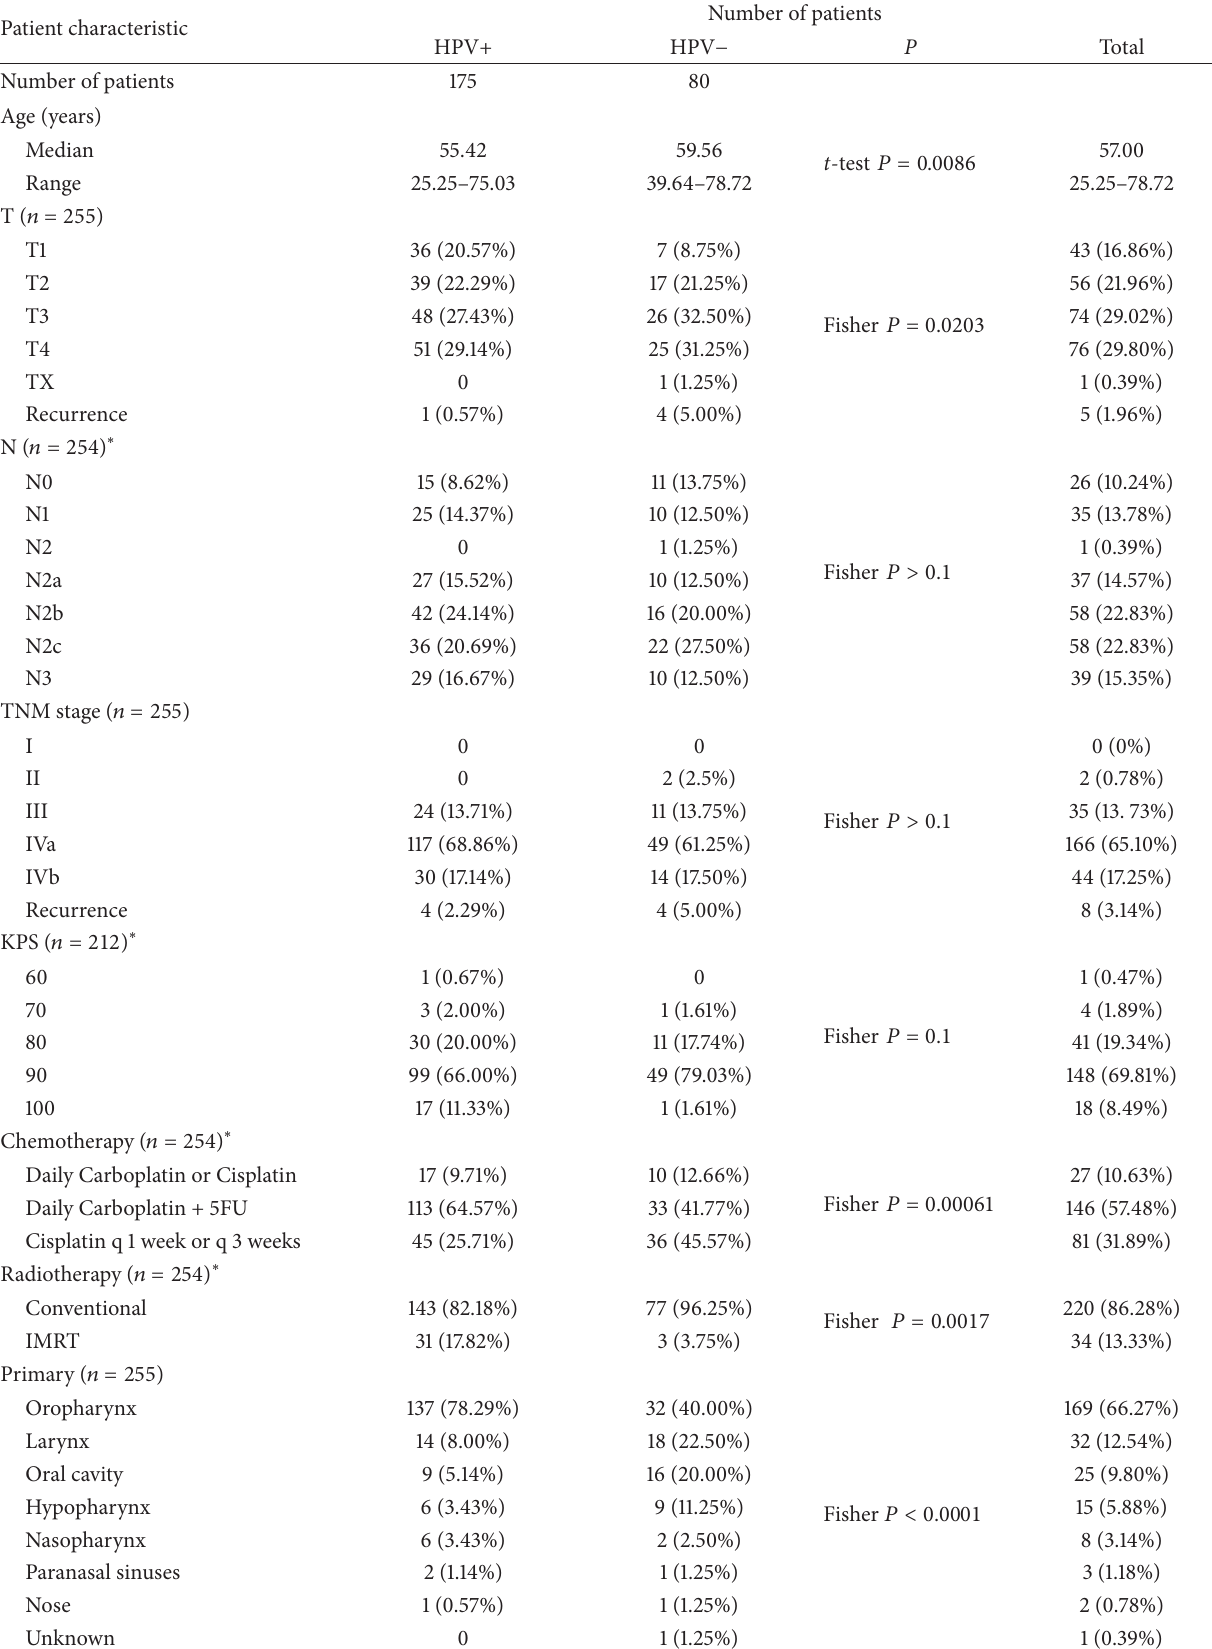
Table 1: Patient characteristics according to HPV